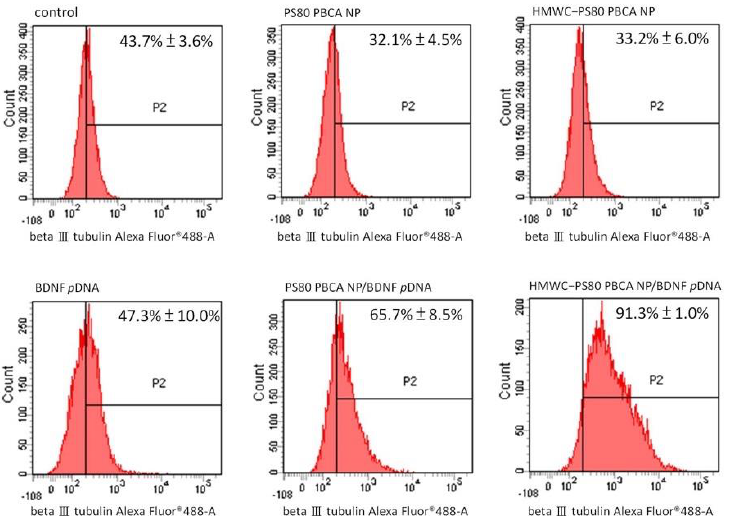
Figure 11. Flow cytometry analysis for the expression of neuron-specific beta III tubulin at day-7 post-transfection with the respective agents. Significant differences to the control in the proportion of beta III tubulin-positive cells were observed only for PS80 PBCA NP/BDNF p DNA and HMWC-PS80 PBCA NP/BDNF p DNA polyplexes. Furthermore, the latter formulation exhibited a significantly higher percentage than the former. p < 0.05.